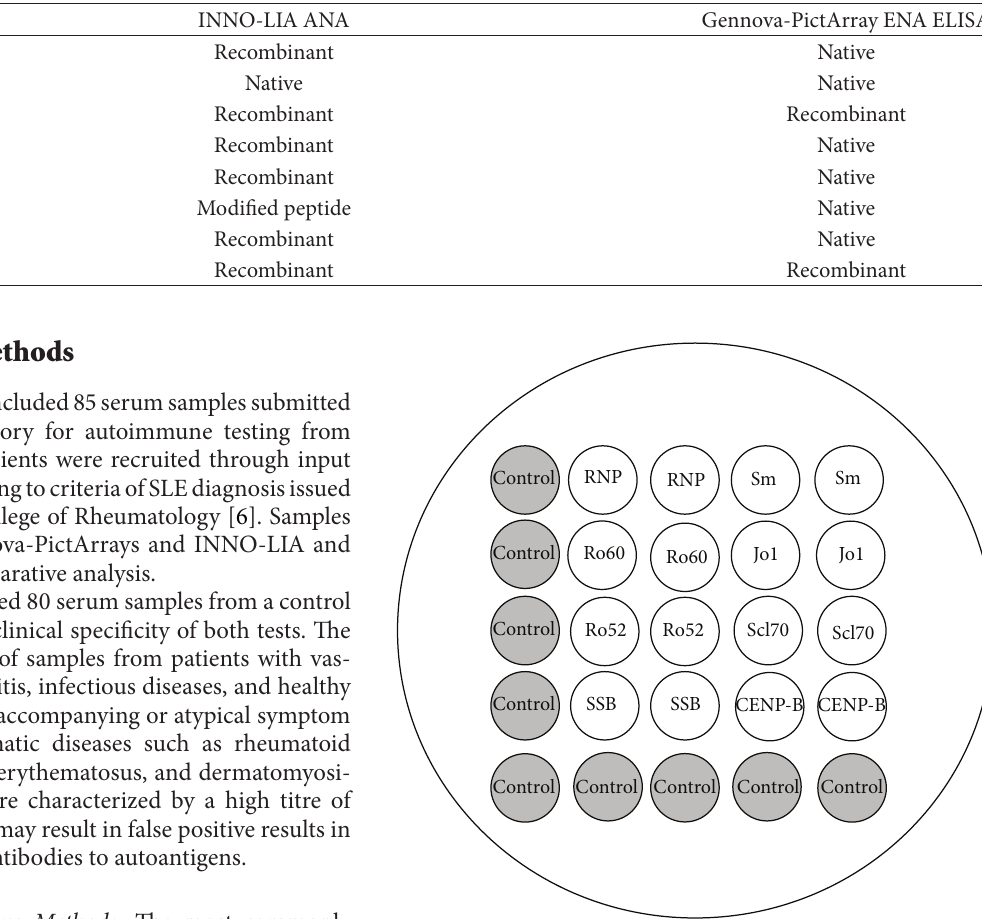
Figure 1: Gennova-PictArray layout for ENA panel including assay controls: RNP/Sm, SSA (Ro60), SSA (Ro52), SSB, Sm Antigen, Jo1, Scl70, and